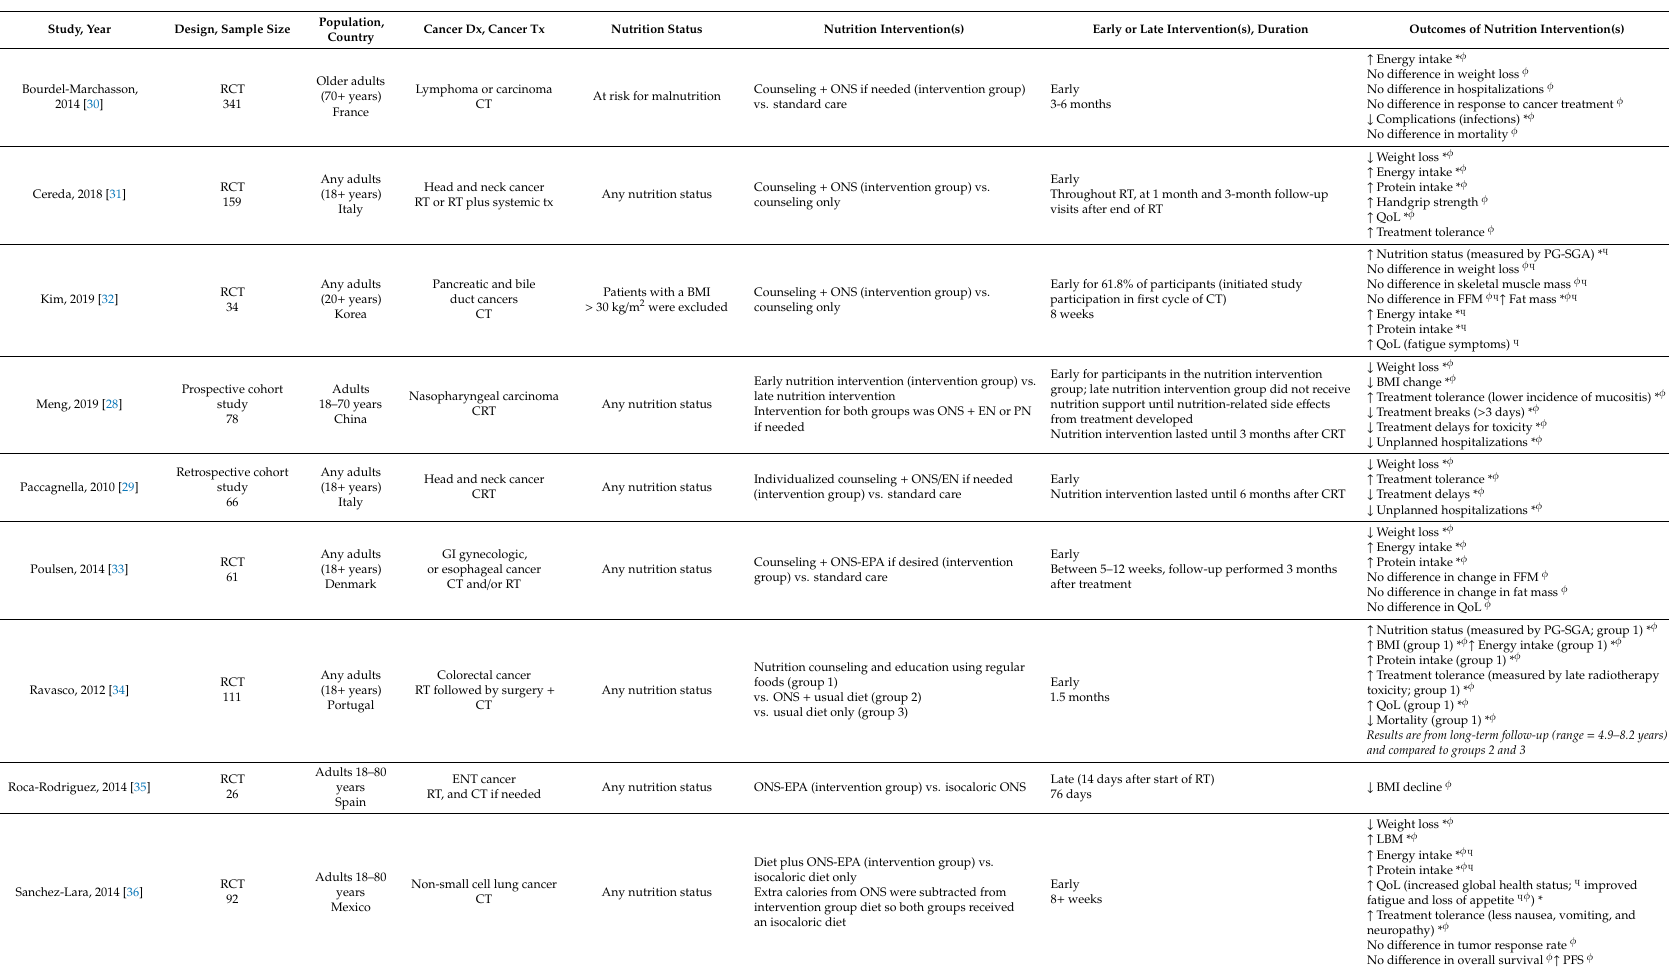
Table 3. Summary of studies included in review of incorporation of nutrition interventions as a component of cancer